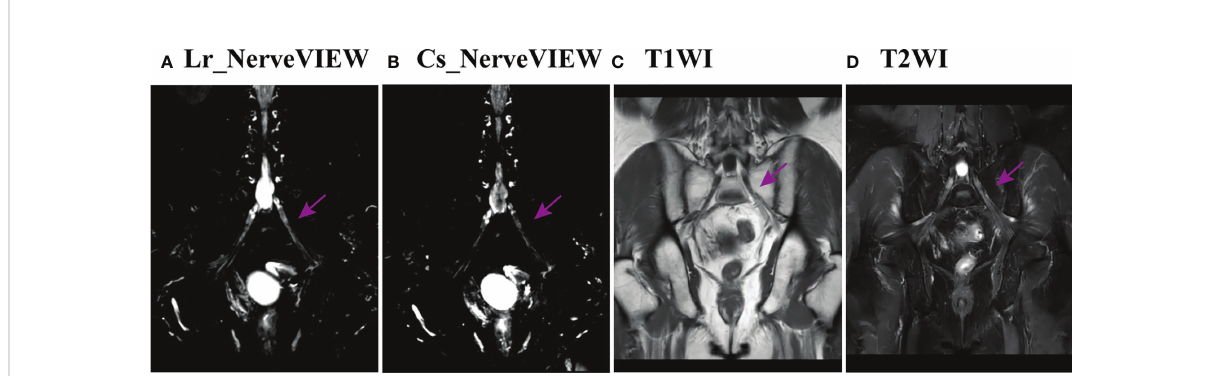
FIGURE 3 Example of the LSP structure in Lr_NerveVIEW (A) , cs_NerveVIEW (B) , T1-weighted (C) sequences, and T2-weighted fat-suppressing sequence (D) in the coronal view from patient #7. The purple arrow indicated the left S1 nerve root. The S1 nerve root was clearly seen on Lr_NerveVIEW and Cs_NerveVIEW sequences but appeared slightly “ brighter ” on the Lr_NerveVIEW sequence. Meanwhile, the same nerve root on T1WI and T2WI sequences appeared vaguer and had worse differentiation with surrounding